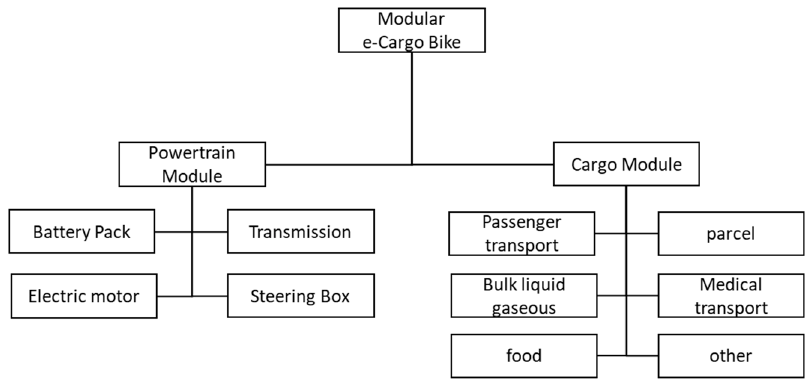
Figure 2. Breakdown structure of the modular e-CB.